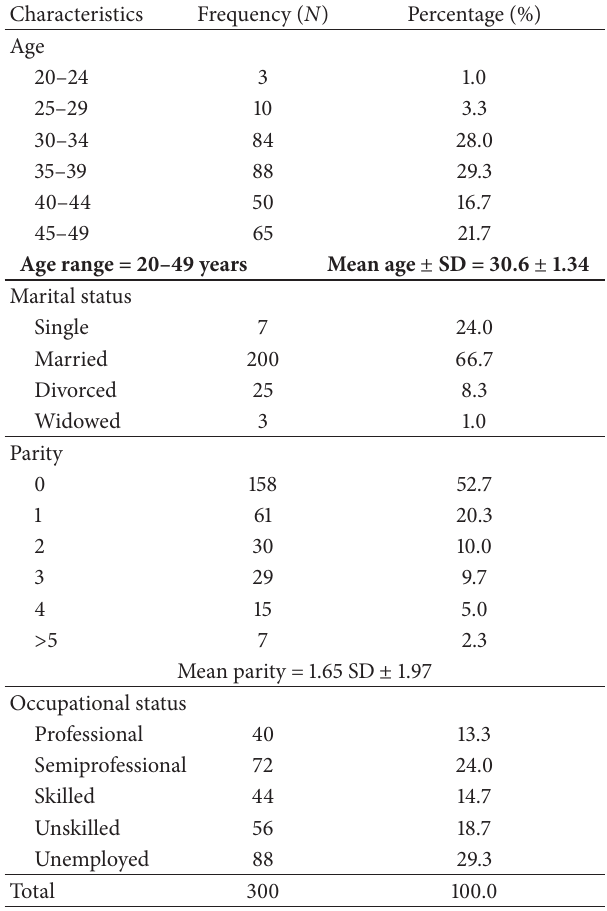
Table 1: Sociodemographic characteristics of the respondents (𝑛 = 300)